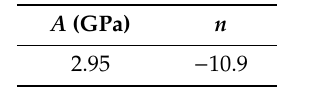
Table 1. Parameters for the rate-independent